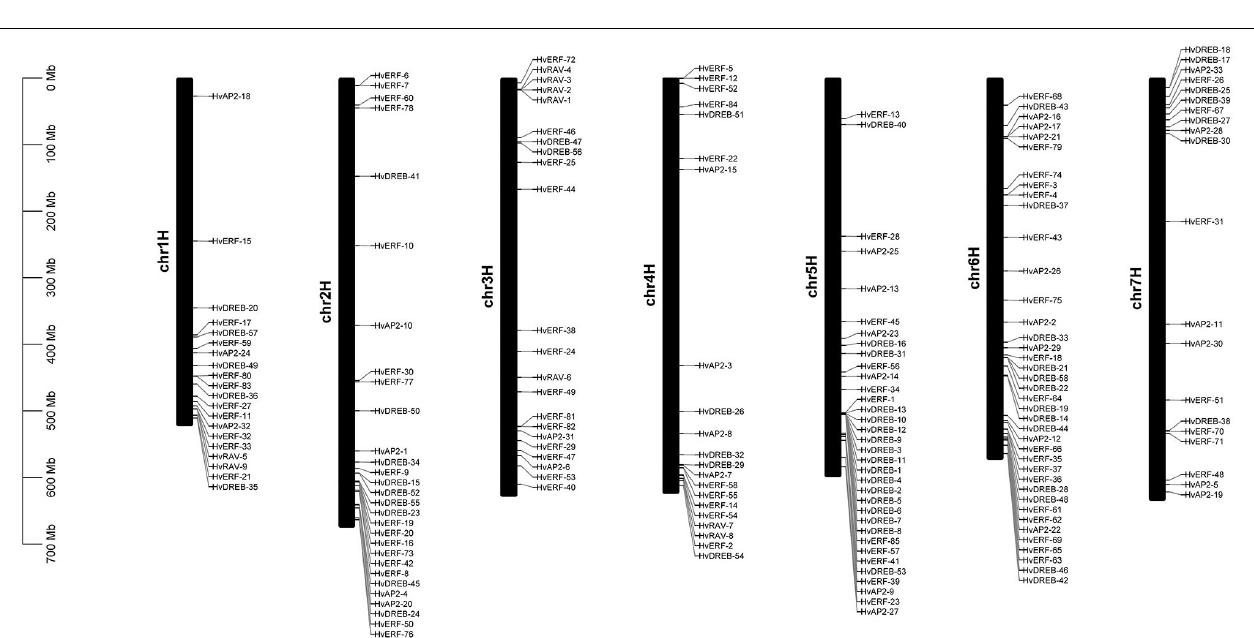
FIGURE 4 | Chromosome distributions of HvAP2/ERF genes in barley.